Question: According to the figure, is the described quantity increasing or decreasing?
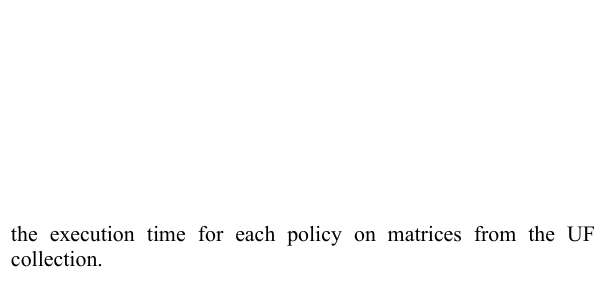
Answer: increasing